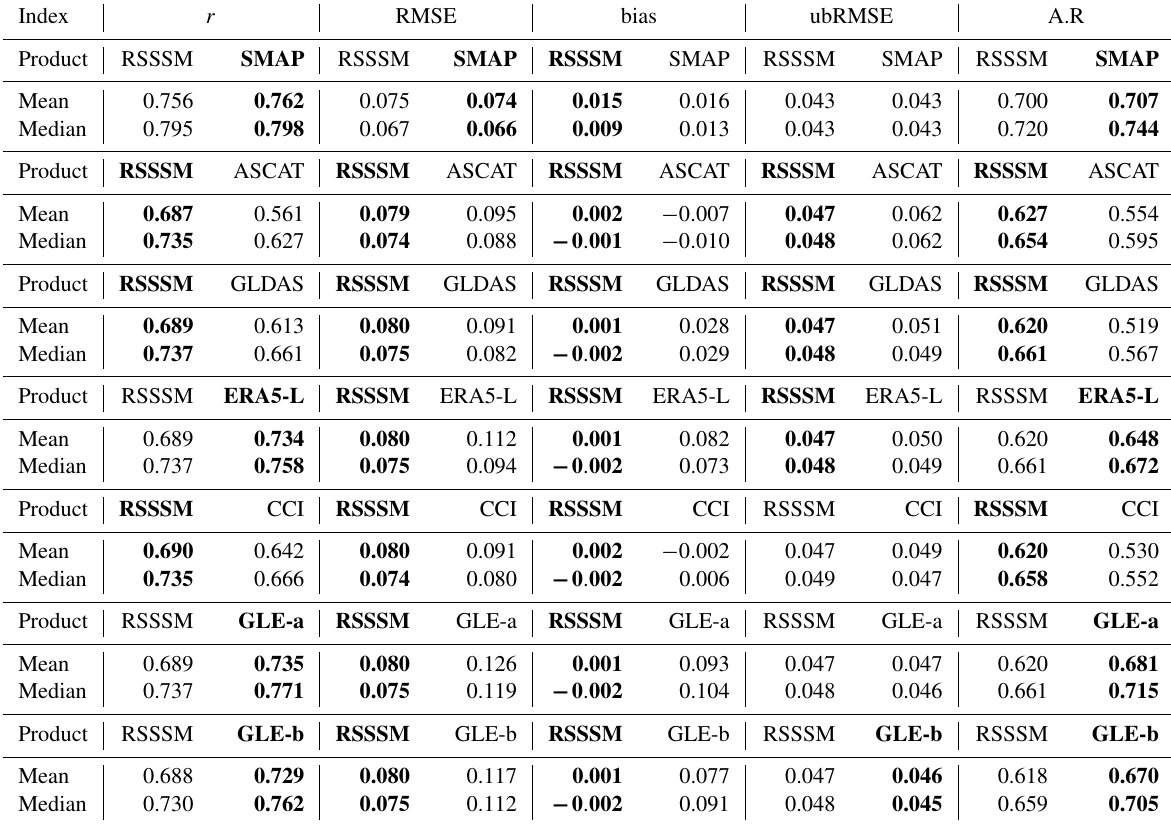
Table 3. Mean and median values of the five evaluation indexes (correlation coefficient r , RMSE, bias, unbiased RMSE (ubRMSE), and the anomalies r (A.R)) on the temporal accuracy of the surface soil moisture simulated in this study (RSSSM) and the other surface soil moisture products when validated using the ISMN in situ measurements. Note: (1) for the comparison between the RSSSM and SMAP_E (SMAP) product, the validation period is from April 2015 to 2018; (2) for the comparison between the RSSSM and ASCAT-SWI (ASCAT), the period is 2007–2018; (3) for the comparison between RSSSM and GLDAS Noah v2.1 (GLDAS), ERA5-Land (ERA5-L), CCI, or GLEAM v3.3a (GLE-a) surface soil moisture product, the validation period is 2003–2018; (4) for the comparison between RSSSM and GLEAM v3.3b (GLE-b), the validation period is 2003 to September 2018. For each pair of comparisons based on each evaluation index, the product with the better performance and its values are highlighted in